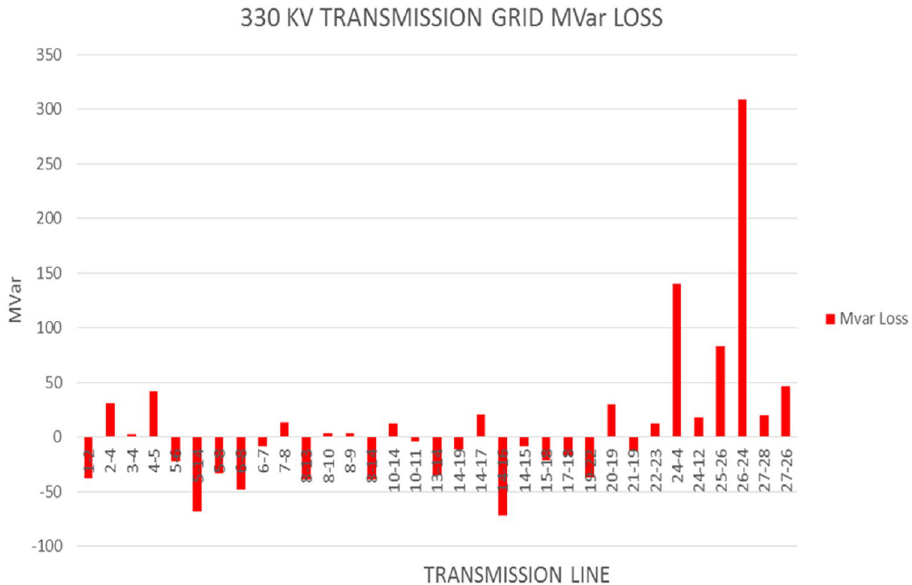
Fig. 9 Reactive power loss of existing 330-kV